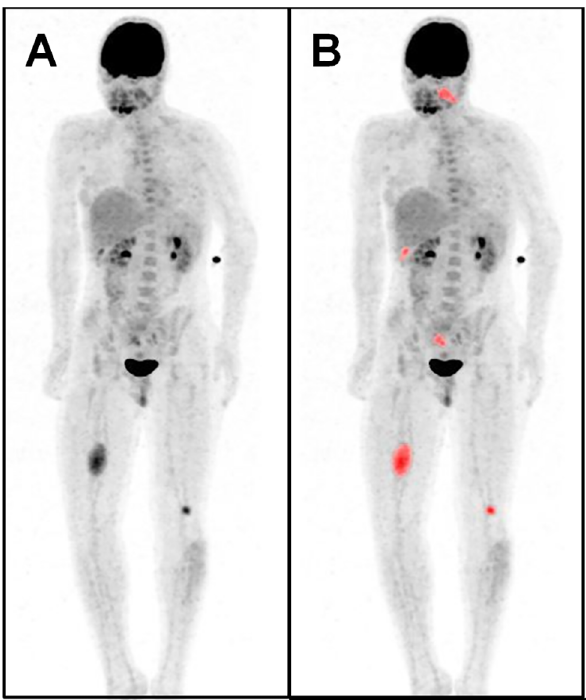
Fig 5. Multiple metabolically active tumors. Maximum intensity projection PET image ( A ) of a patient with a MPNST in the right upper leg (SUV max / MTV / TLG: 5.3 / 63488 / 190464), plexiform neurofibromas in the left head and neck area (SUV max / MTV / TLG: 3.6 / 17088 / 42720), below the right liver lobe (SUV max / MTV / TLG: 3.7 / 3584 / 8960), in the right pelvis (SUV max / MTV / TLG: 2,5 / 6435 / 14157) and in the left upper leg (SUV max / MTV / TLG: 5.3 / 4096 / 13107). Automatically delineated metabolically active tumor volumes ( red ) ( B ).